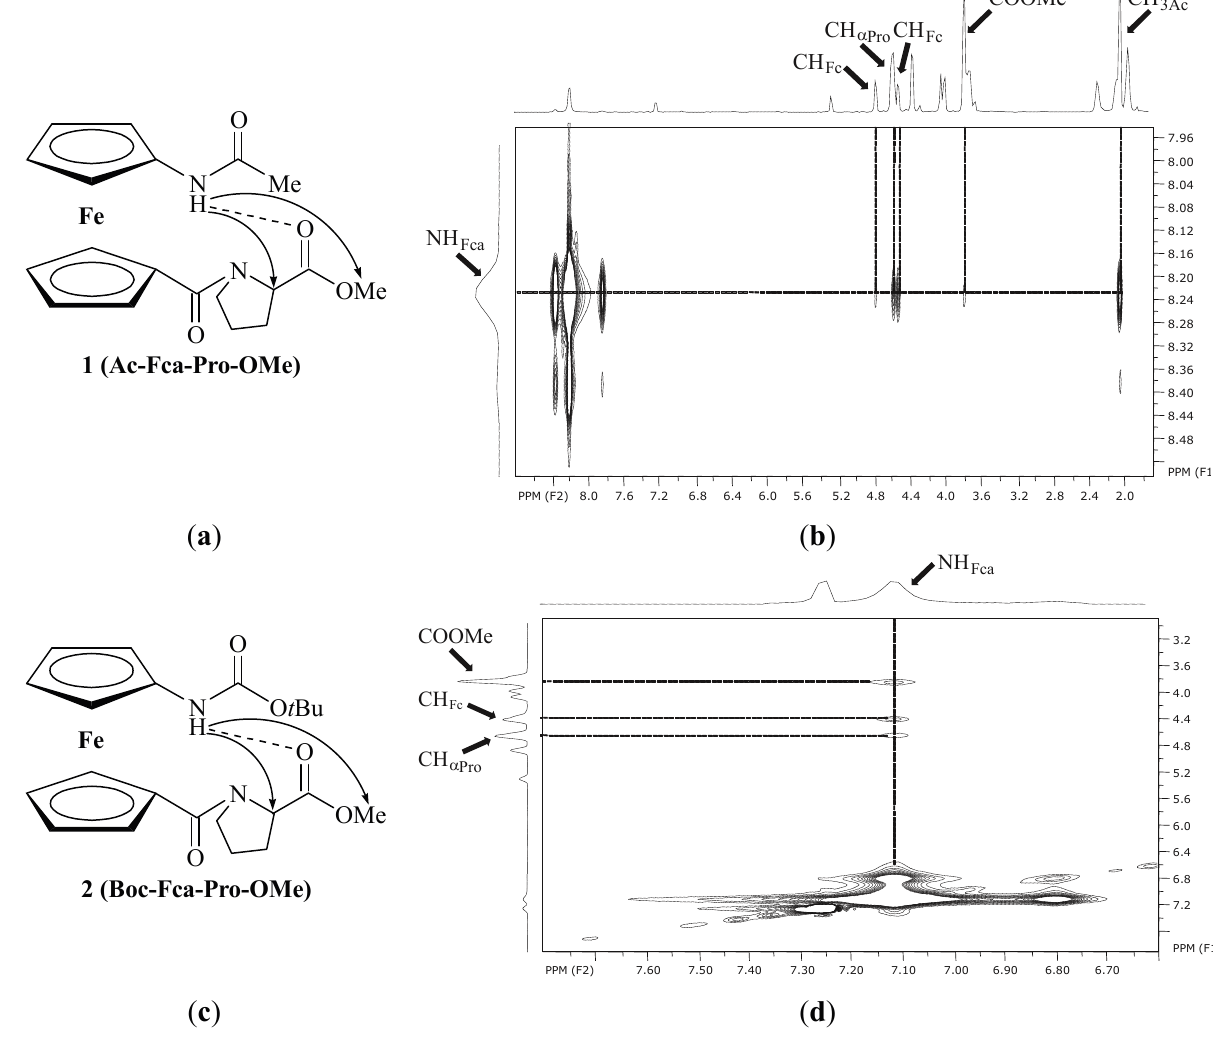
Figure 5. The proposed IHBs in peptides 1 ( a ) and 2 ( c ) are depicted with dashed lines and the interchain NOE connectivities are presented with arrows; the interchain NOE connectivities between the C - and N -termini of 1 ( b ) and 2 ( d ) are depicted with dashed lines.